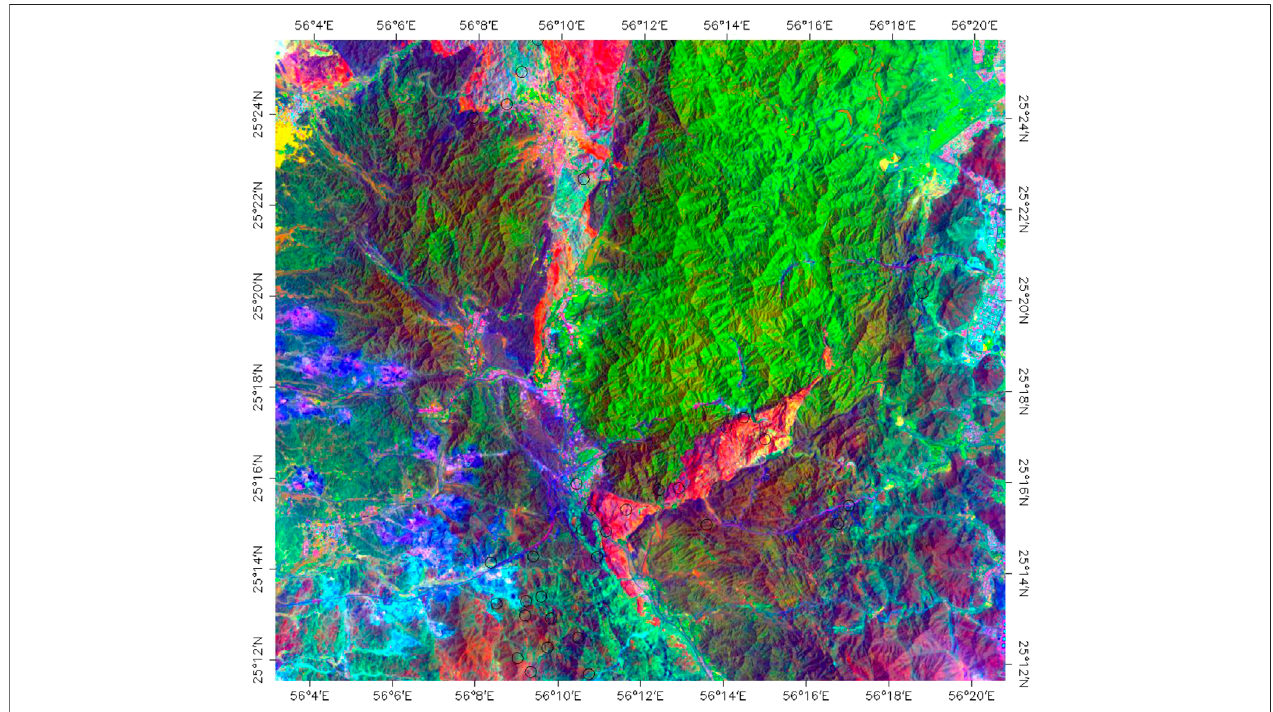
FIGURE 17 | False color composite images of decorrelation stretching of band combination 7:6:2 displayed in RGB for the study area. The pinkish blue pixels represent metamorphic sole, while copper mineralization zones are displayed in the green color. The locations of copper are shown in black circles.